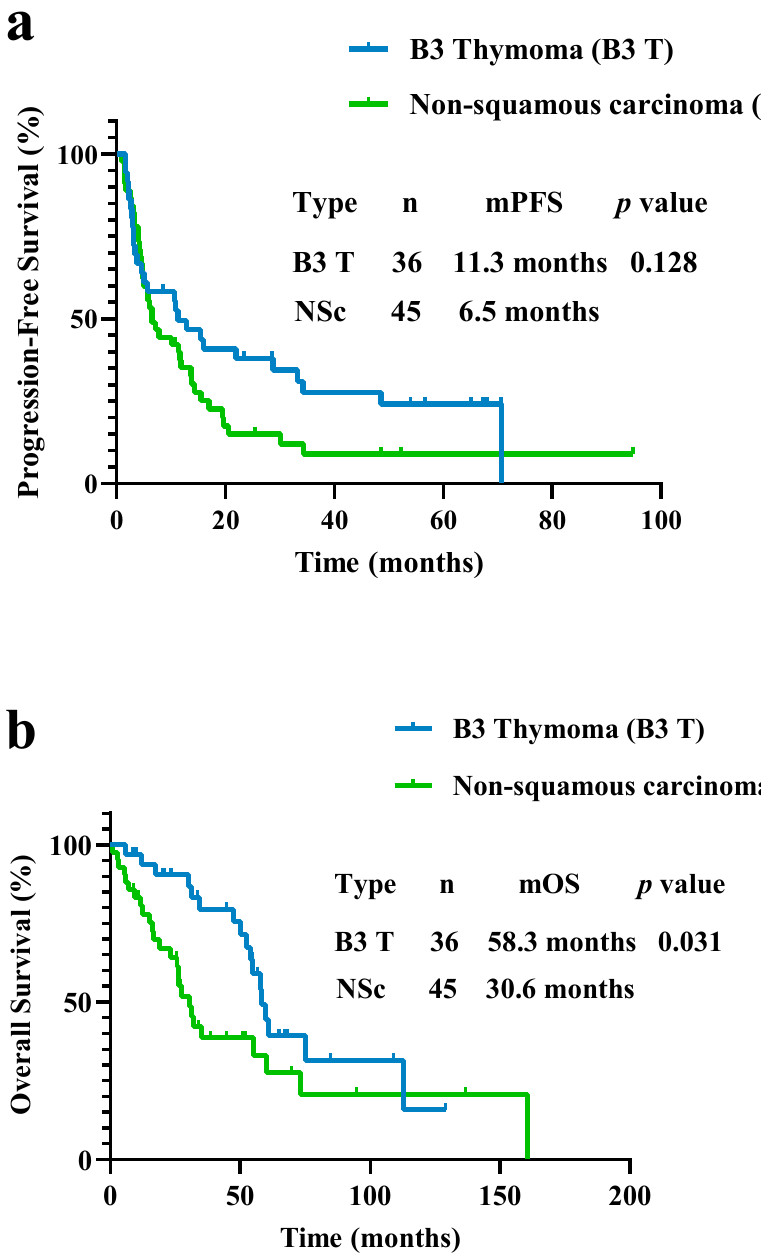
Figure 3. ( a ) PFS and ( b ) OS in patients with B3 thymoma and non-squamous carcinoma. PFS did not differ between patients with B3 thymoma and non-squamous carcinoma (PFS, 11.3 vs. 6.5 months, p = 0.128). OS was different between patients with B3 thymoma and non-squamous carcinoma (OS, 58.3 vs. 30.6 months, p = 0.031).